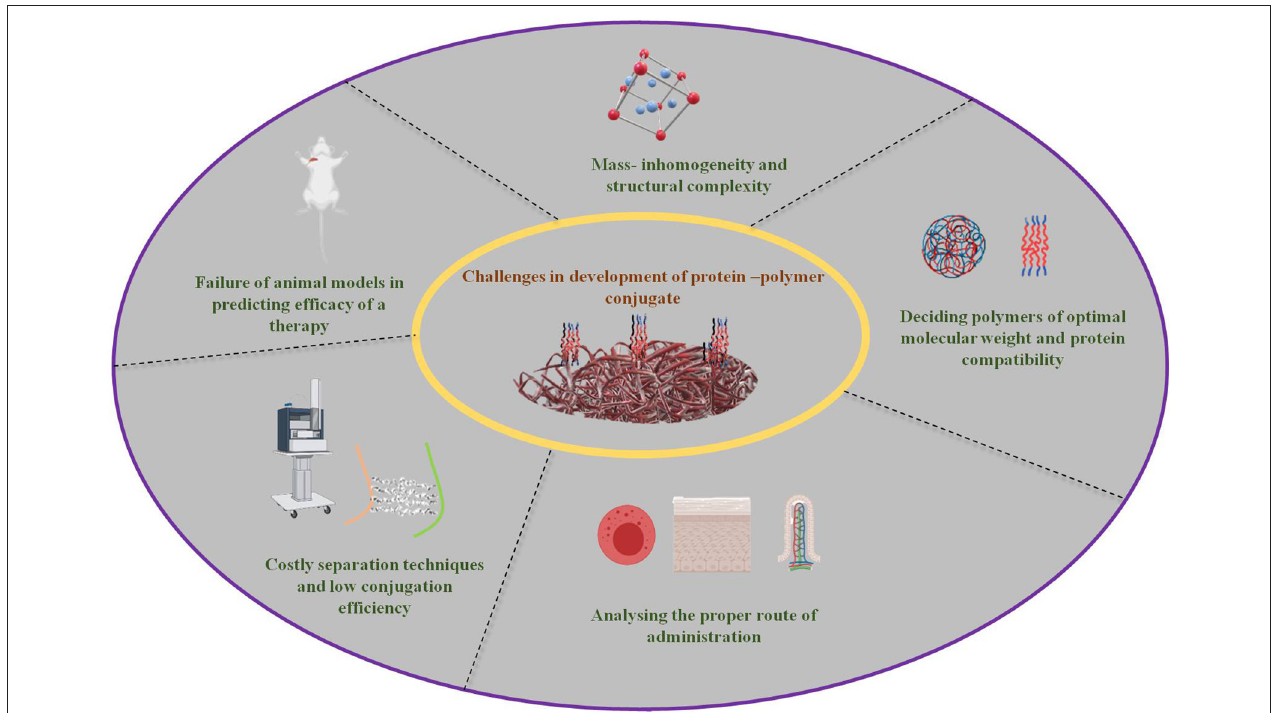
FIGURE 4 | Major challenges for the conjugation of protein and polymers hampering their further developments (created with